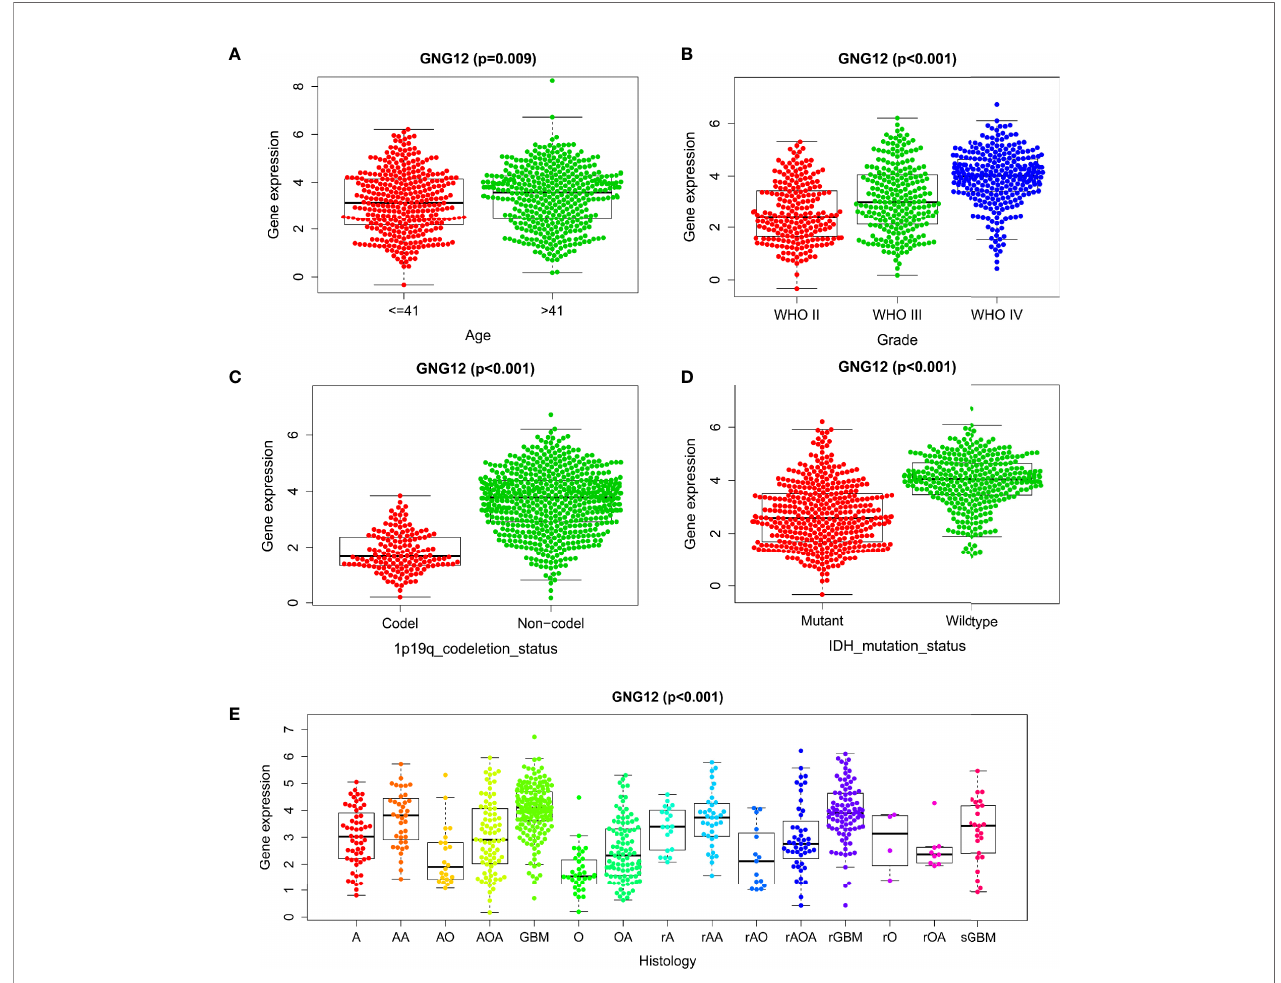
FIGURE 2 | Correlation between GNG12 and different clinical characteristics based on CGGA database. (A) age. (B) WHO grade. (C) 1p19q co-deletion. (D) IDH mutation. (E)